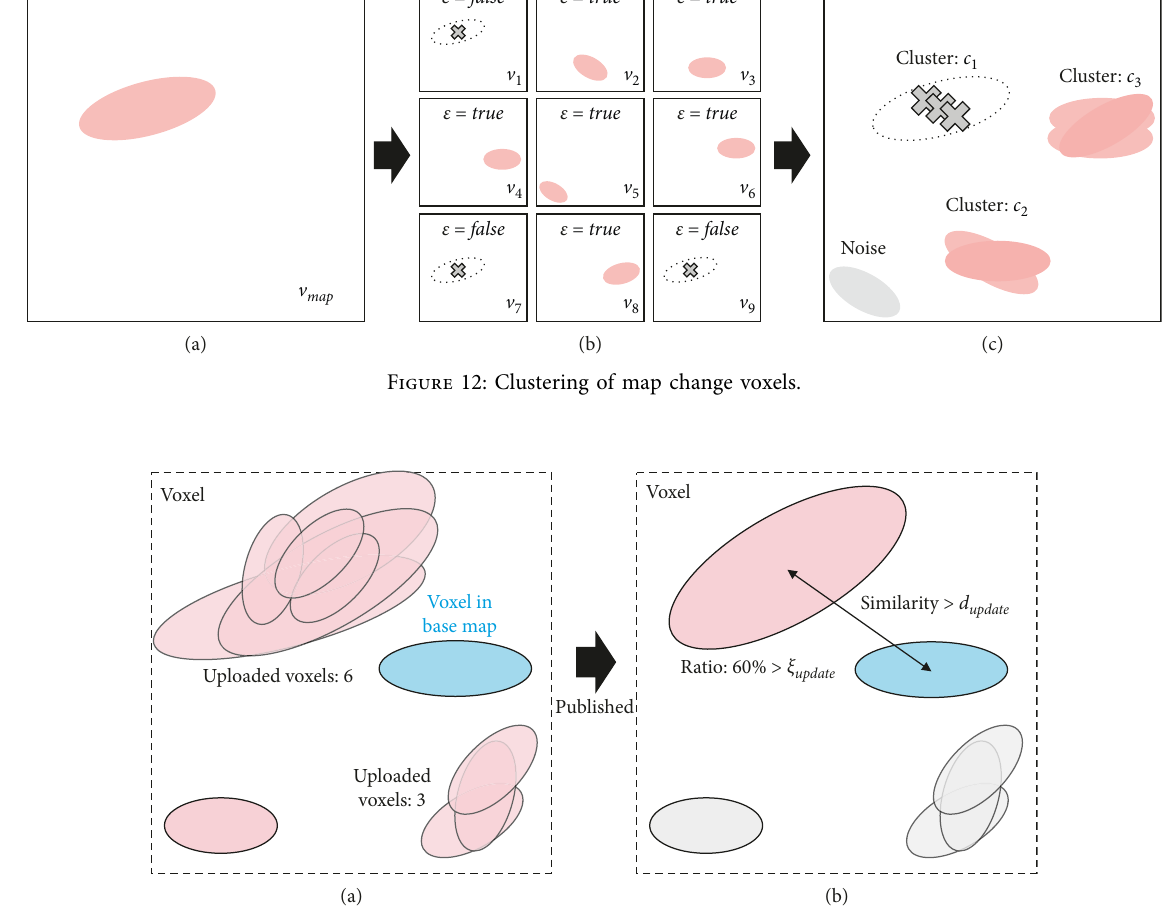
Figure 13: Publication of map changes into the base map.